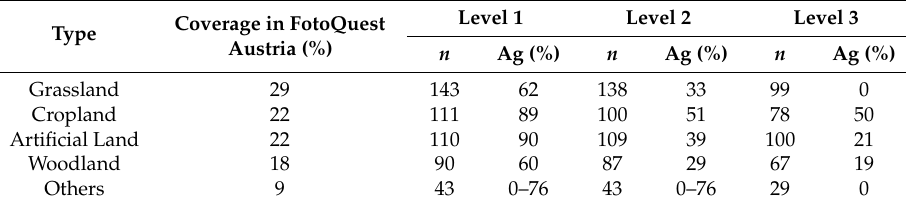
Table 6. Land cover main agreement (Ag) areas (sorted by percentage covered in FotoQuest Austria) between the two systems. Number of observations ( n ) is shown.